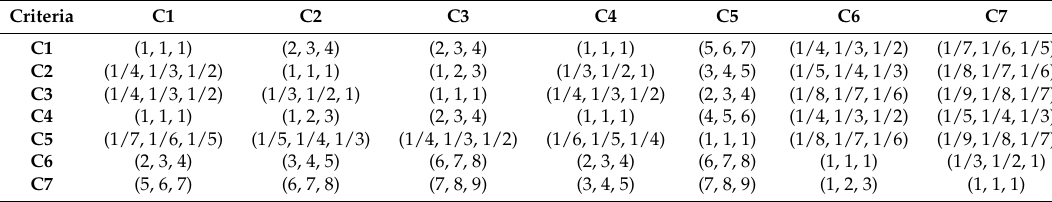
Table 5. Fuzzy Comparisons for each criteria (Expert